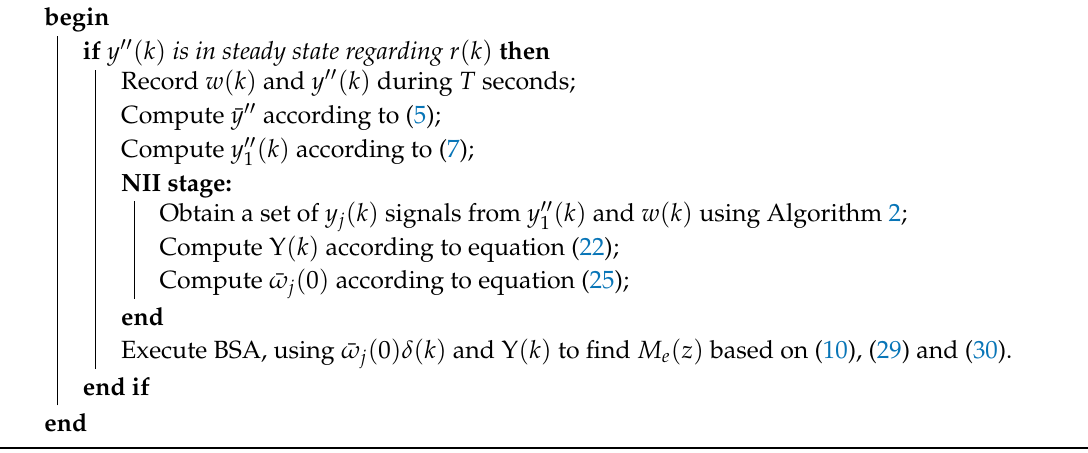
Algorithm 3: Attack Identification with the NII